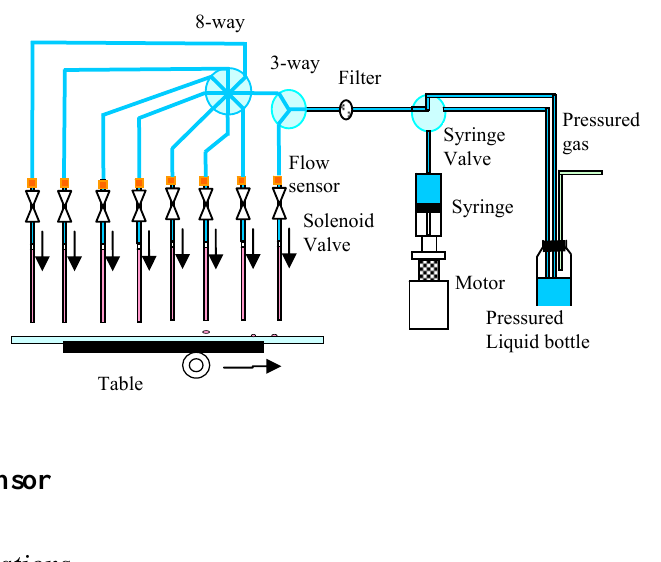
Figure 1. The schematic of the non-contact adaptive precise liquid dispensing system.